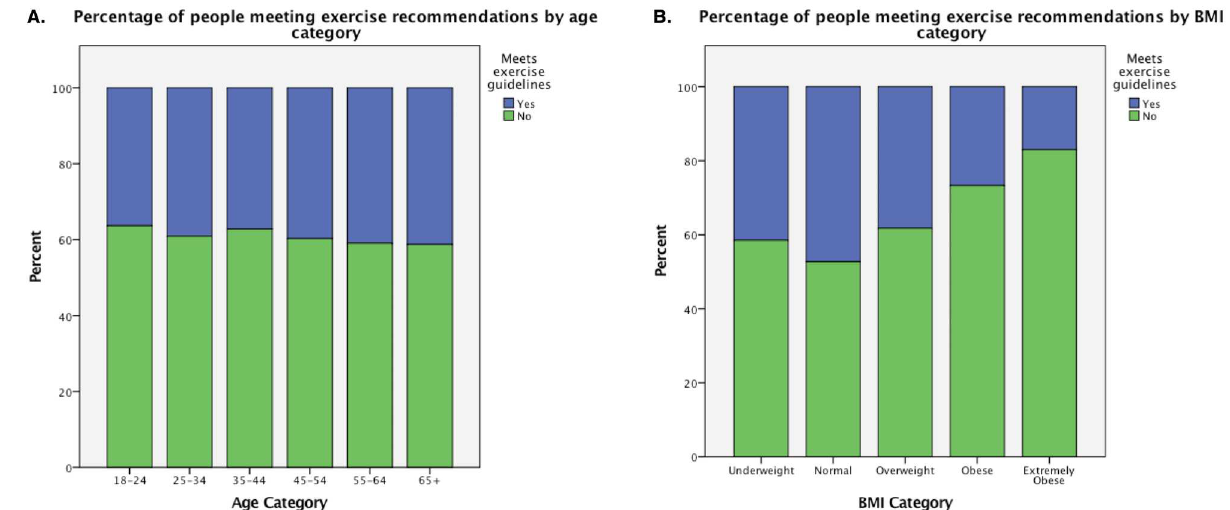
Fig 4. Percentage of people meeting exerciserecommendations by age and BMI category.